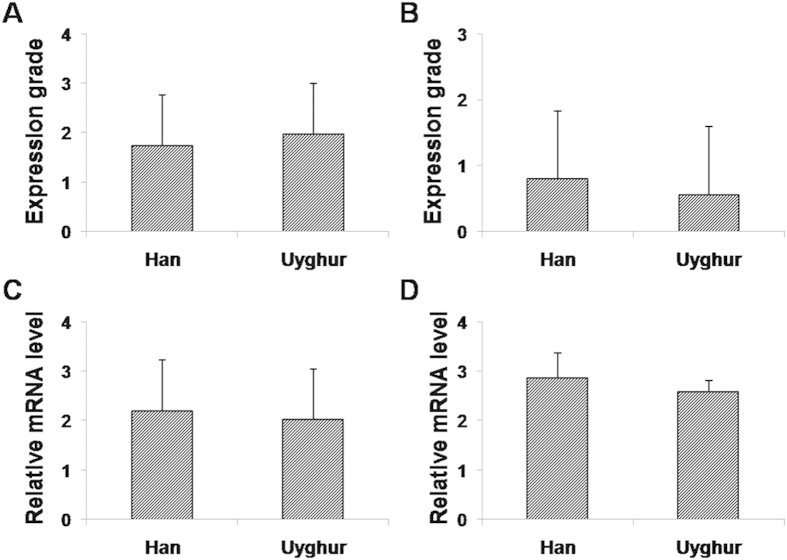
Expressions of α-SMA and CD34 in the Uyghur and Han patients with breast lesions.The expression levels of α-SMA and CD34 were detected by immunohistochemistry (A,B) and real-time PCR (C,D), respectively, in Uyghur and Han patients with breast lesions. (A,B) The protein expression levels of α-SMA (A) and CD34 (B) were detected by immunohistochemistry in Uyghur and Han patients. (C,D)The mRNA expression levels of α-SMA (C) and CD34 (D) were detected by real-time PCR in Uyghur and Han patients. Compared with the benign lesions, *P < 0.05.